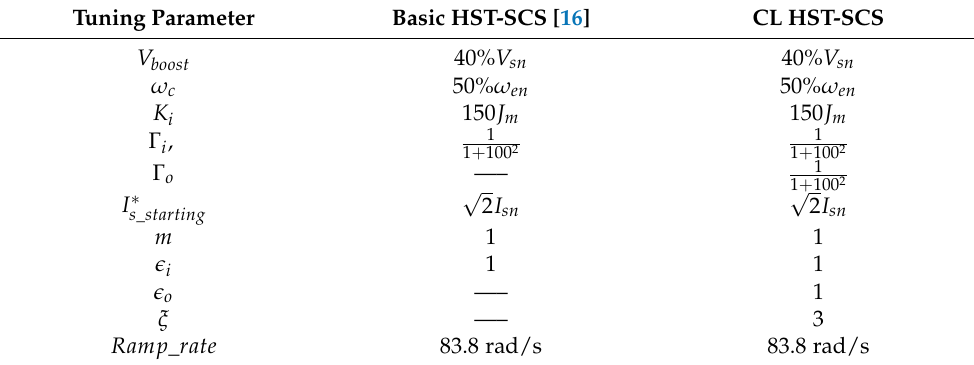
Table 2. Tuning parameters for basic HST-SCS [16] versus CL